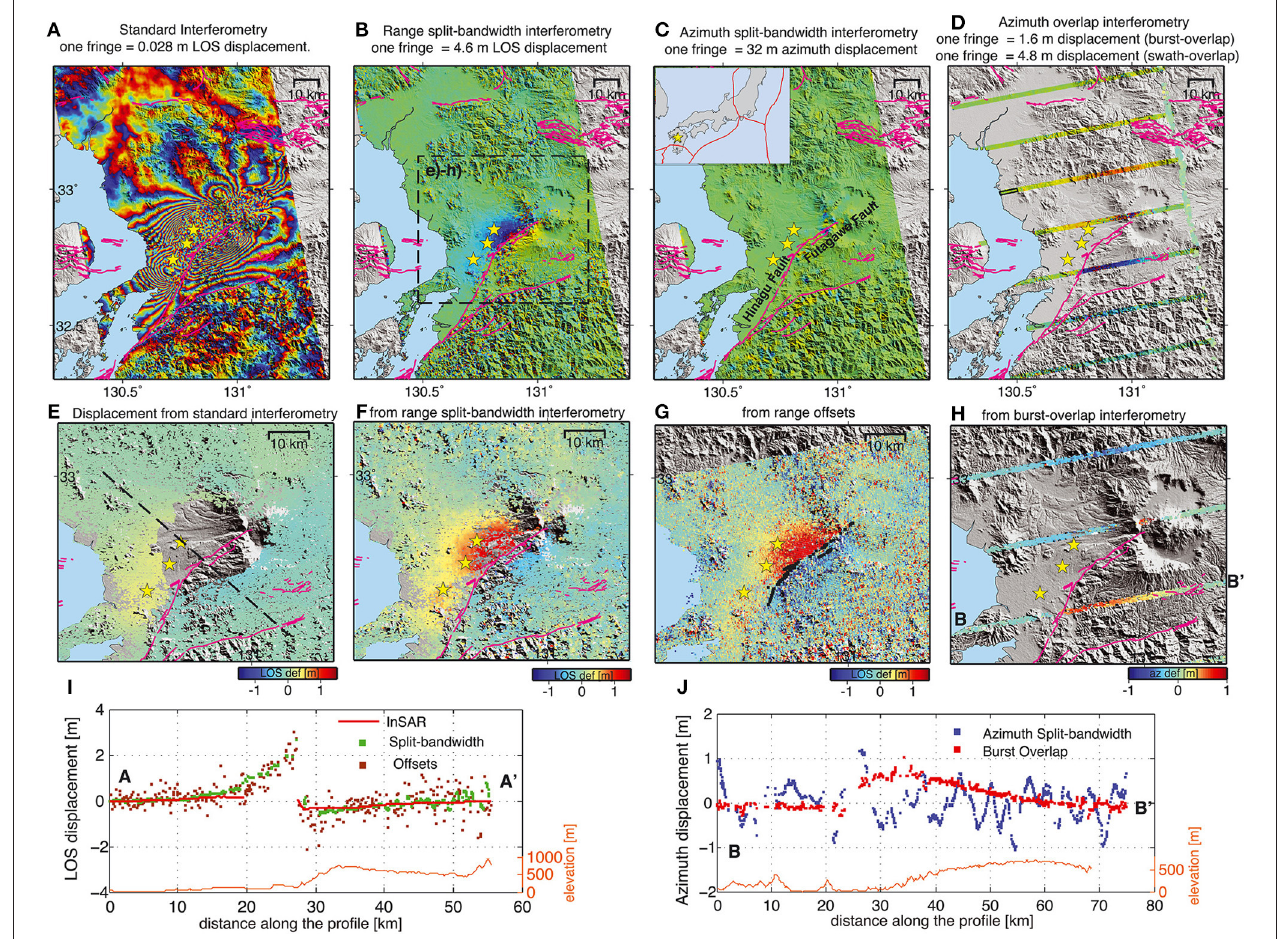
FIGURE 3 | Coseismic deformation of the Mw 7.1 April 16, 2016 Kumamoto, Japan, earthquake based on ascending Sentinel-1a TOPS imagery acquired on 08 April 2016 and 20 April 2016. (A) Wrapped DInSAR phase. (B) Range split-bandwidth InSAR phase. (C) Azimuth split-bandwidth InSAR (MAI) phase. (D) Burst Overlap MAI phase. (E) DInSAR LoS deformation (positive away from the satellite). (F) Range-SBI LoS deformation. (G) Offset-tracking LoS deformation, (H) Burst Overlap MAI azimuth deformation (positive opposite to the azimuth direction). (I) LoS deformation profiles along the dashed line in panel (E) taken from the deformation maps in panels (E–G) . (J) Azimuth deformation profiles between points B and B’ in panel (H) based on panels (C,H) . The earthquake locations (yellow stars) are from the Global Centroid Moment Tensor project. The mapped faults are indicated as magenta lines. Reproduced with permission from Figure 2 in Jiang et al. (2017a). © 2017. American Geophysical Union. All rights